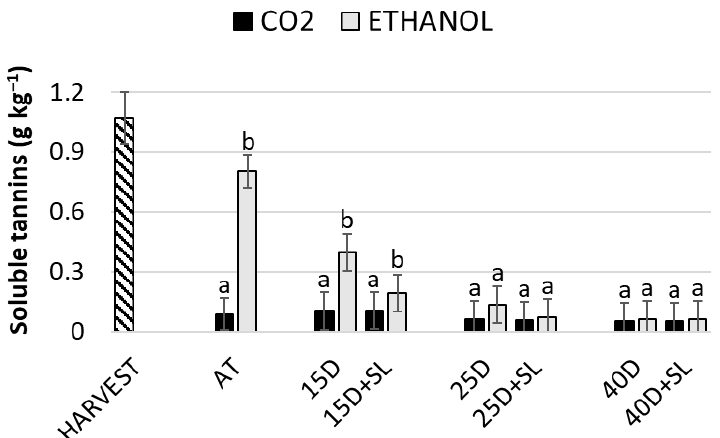
Figure 1. Changes in the soluble tannins of the ‘Giombo’ persimmon treated with CO 2 or ethanol during cold storage (1 ◦ C) and after shelf-life simulation (5 more days at 20 ◦ C). AT: One day after deastringency treatment, D: Days of cold storage; SL: Shelf-life simulation. The vertical bar represents the least significant difference (LSD) intervals ( p ≤ 0.05) (interaction treatment–storage days). Different letters above bars indicate significant differences among treatments at each moment of evaluation ( p ≤ 0.05).